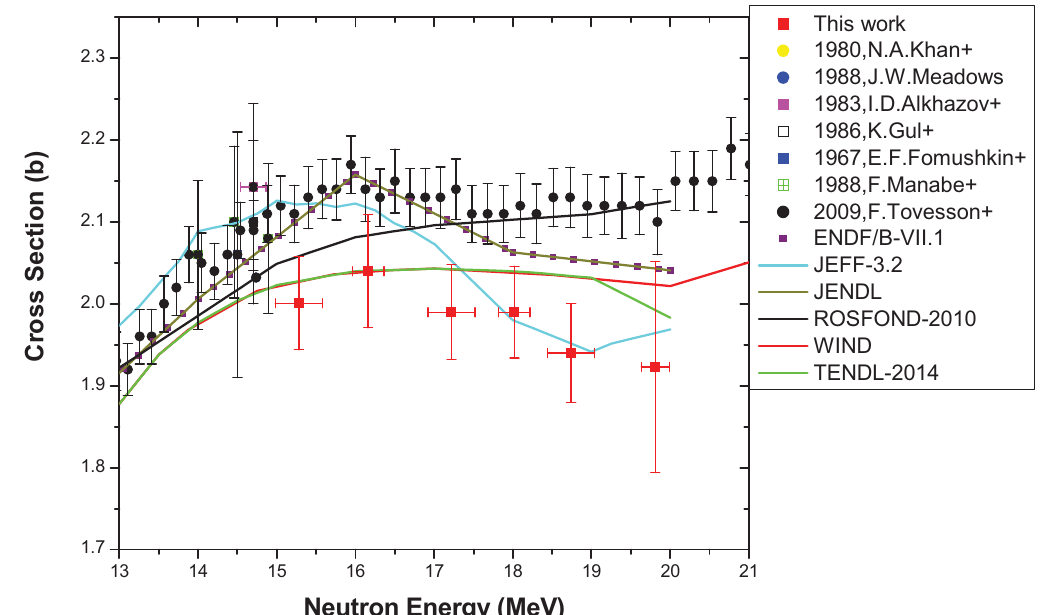
Figure 5. Neutron-induced fission cross section of 242 Pu(n,f) using 238 U(n,f) (ENDF/B-VII.1) as reference